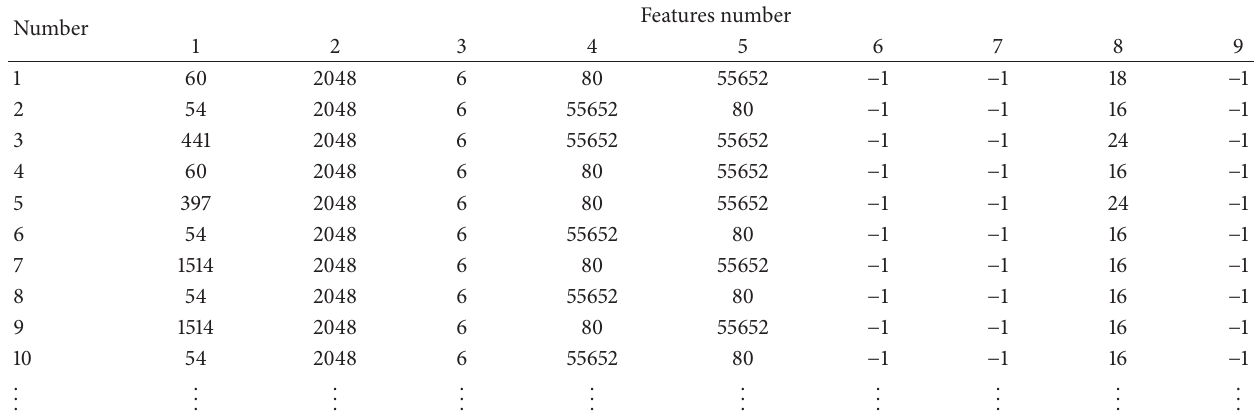
Table 4: Statistics for a piece of network traffic after quantization.